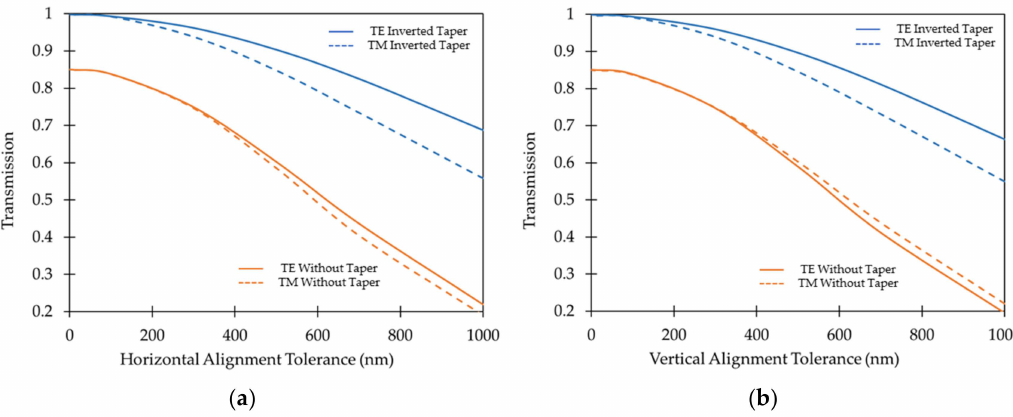
Figure 3. Optical simulation results for EME simulations showing the transmission e ffi ciency of TE and TM modes between two butt-coupled SiN waveguides with and without inverted tapers as a function of: ( a ) horizontal and ( b ) vertical alignment